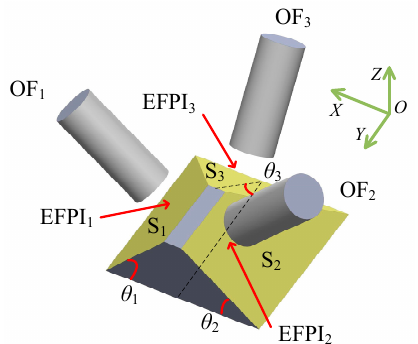
Figure 1. A schematic diagram of the triaxial displacement sensor. The sensor consists of an optical fiber component and a mirror component. OF represents optical fiber. Three EFPIs are formed by the endfaces of the three optical fibers and their corresponding mirrors. The inclined surfaces S 1 , S 2 , and S 3 have angles of inclination θ 1 , θ 2 , and θ 3 (0° < θ 1 , θ 2 , θ 3 < 90°) with respect to the XOY plane, respectively. A 3D coordinate system, XYZ , is defined in the figure.